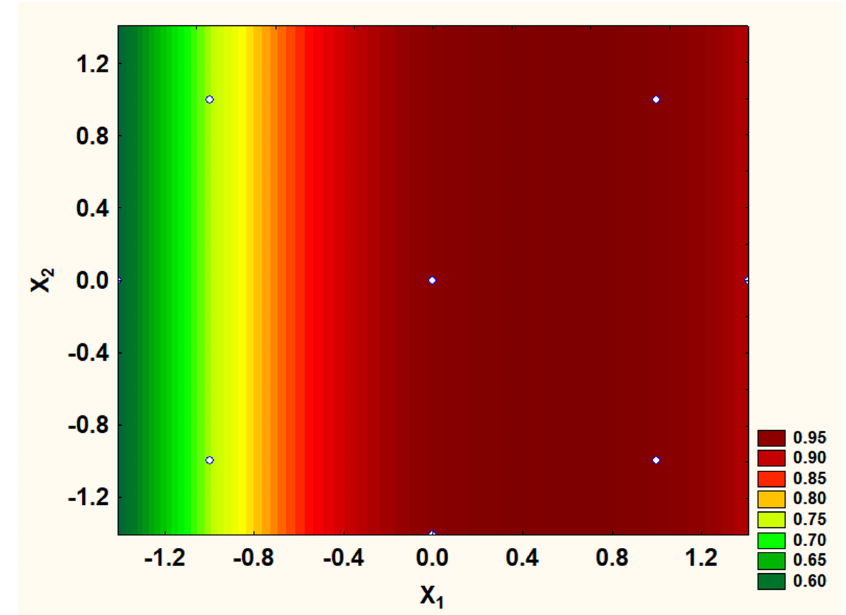
Figure 3 - Contour graph of ferrous ions and hydrogen peroxide concentrations for the color removal of the textile effluent. X the coded concentration for hydrogen